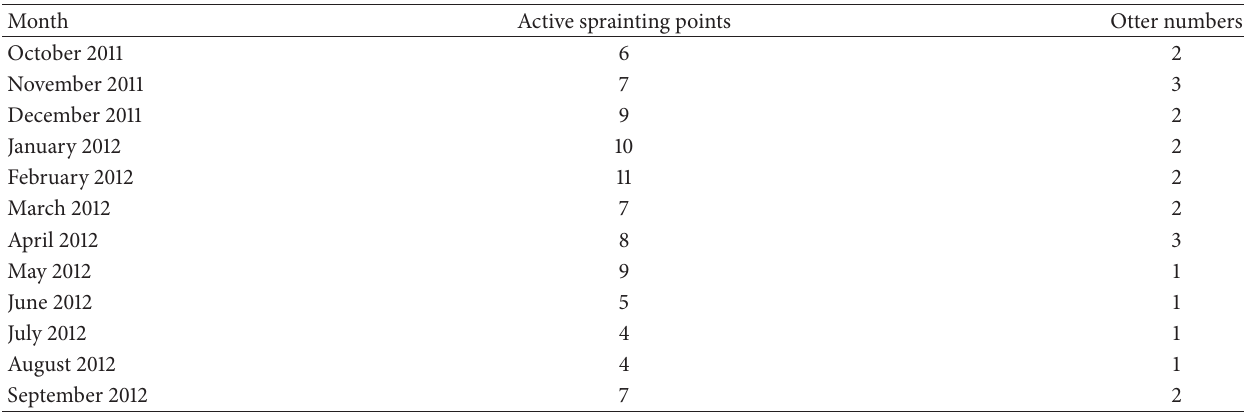
Table 2: Active sprainting points and otter numbers at Loch na Dal.